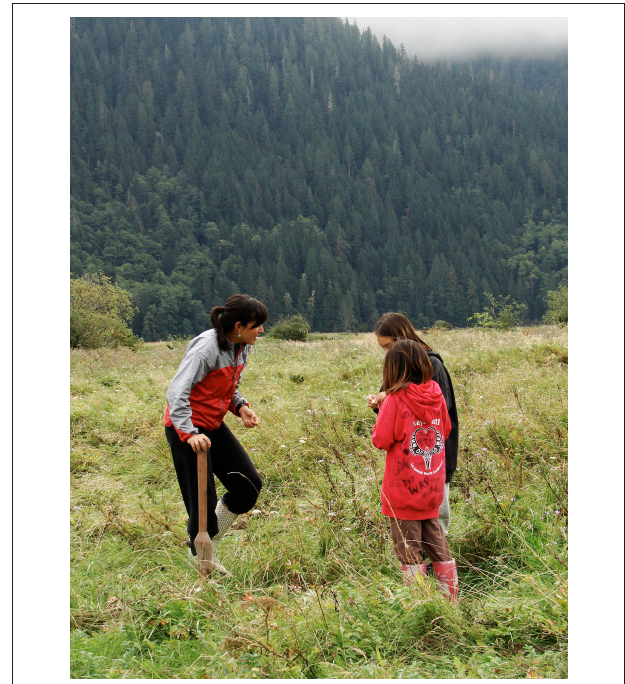
FIGURE 5 | Styawat learning about Indigenous plants with girls from Gwayi Village, Kingcome Inlet.